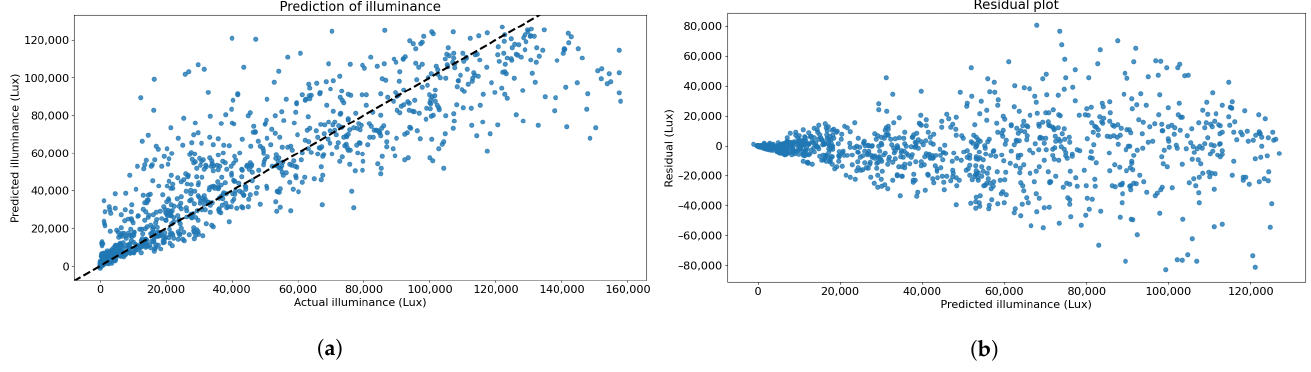
Figure 9. Quantitative evaluation from the experiment using the XGBoost model with a 3-day window size. ( a ) Relationship between predicted and actual illuminance values. ( b ) Plot of the residual against the predicted